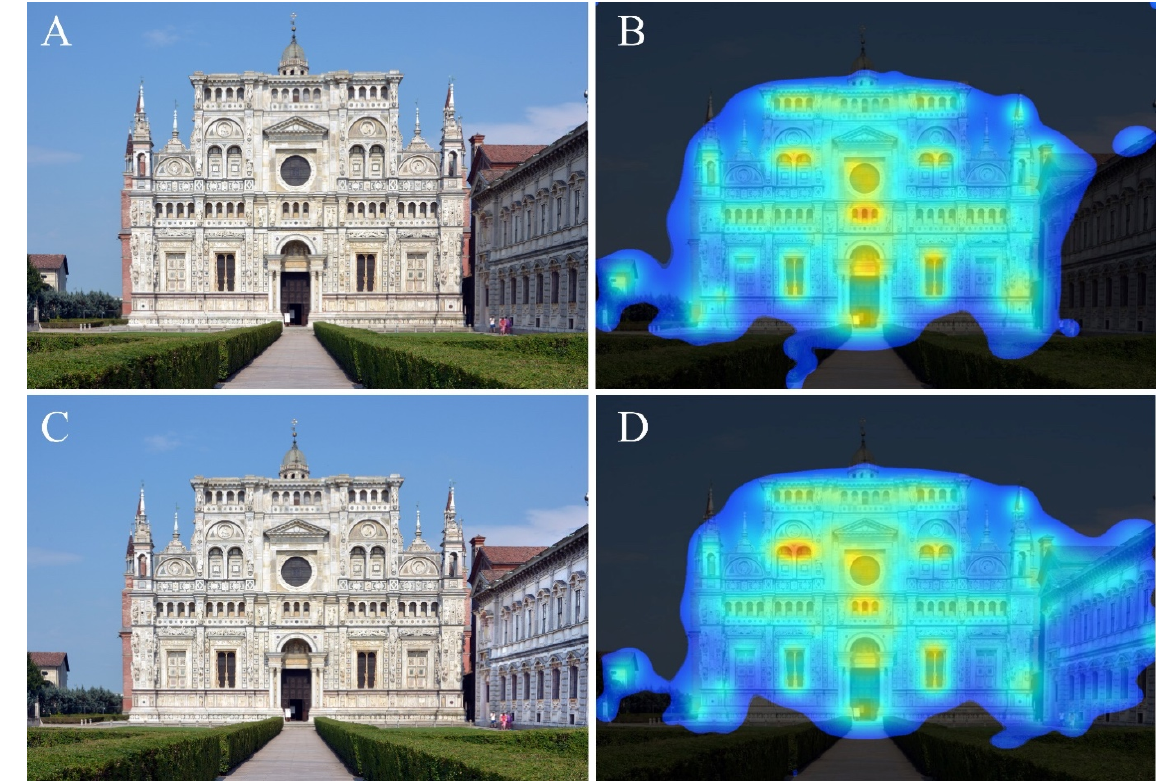
Figure 2. The church of the Certosa di Pavia monastery in Pavia, Italy. ( A ), original photograph; ( B ) visual attention heatmap misses the part of the building in shadow; ( C ), the same photograph after increasing the brightness and contrast of the wing that is in shadow; ( D ) the visual attention heatmap of adjusted visual now includes the part of the building originally in shadow.